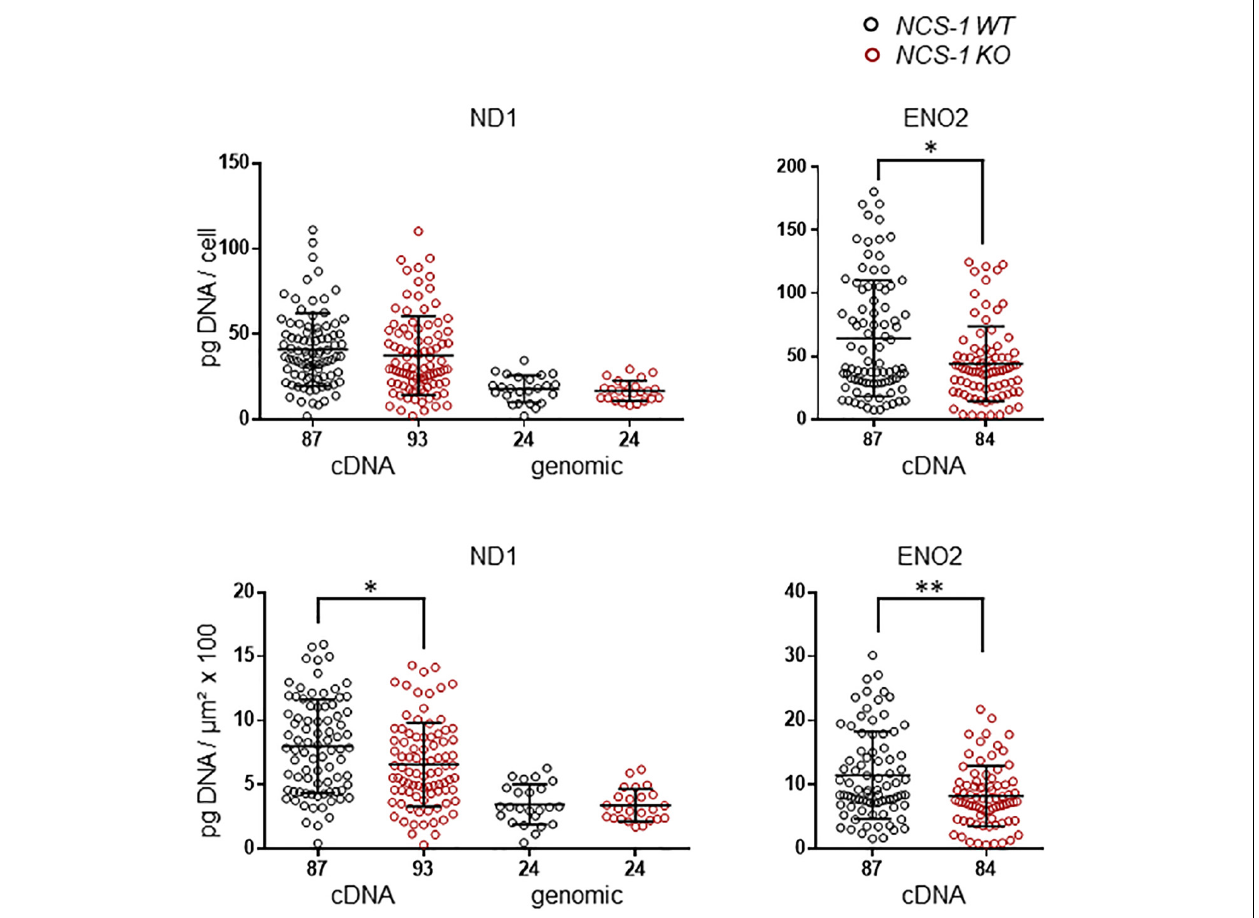
FIGURE 2 | Lower relative cDNA levels of ND1 and ENO2 in SN DA neurons from NCS-1 KO mice compared to WT. Left: qPCR-derived relative cDNA and genomic DNA levels of mitochondrially coded NADH-ubiquinone oxidoreductase chain 1 (ND1) in individual TH positive SN DA neurons from juvenile NCS-1 KO and WT mice, relative to respective tissue cDNA derived standard curves (in pg/cell, upper), and in addition normalized to specific laser-microdissected neuron sizes (in µ m 2 × 100, lower). Note that ND1 cDNA levels reflect cDNA and also genomic DNA-derived signals, as the mitochondrially encoded ND1 gene contains no intron, but genomic ND1 levels alone are similar between WT and KO. Right: Similar qPCR-derived relative cDNA levels for the same samples as in (A) for the neuron specific enolase (ENO2). Data are given as scatter plots with mean ± SD. Significant differences are indicated according to Mann–Whitney U-tests and marked with asterisks ( ∗ p ≤ 0.05; ∗∗ p < 0.01). Numbers of analyzed individual SN DA neuron-derived cDNA samples (n) are given on the x-axis. All data and statistics detailed in Supplementary Figure S2 and Supplementary Table S2